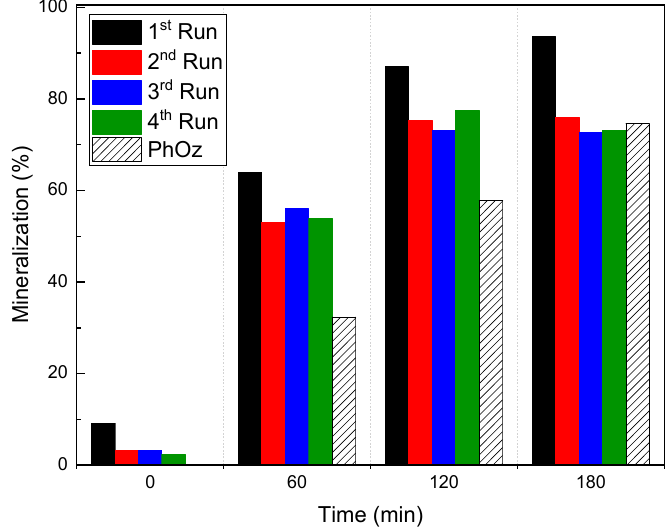
Figure 4. TOC mineralization at different reaction times for the FeGOTi reusability test under PhCatOZ conditions and photolytic ozonation as reference (PhOz). Conditions: gas flow rate, 35 L h − 1 ; inlet ozone gas concentration, 10 mg L-1; primidone, C 0 = 10 mg L − 1 ; TOC 0 = 6.6 mgL − 1 ; catalyst dosage, 0.25 g L − 1 ; agitation speed, 700 rpm. Results at 0 min correspond to dark adsorption for a 30 min period.